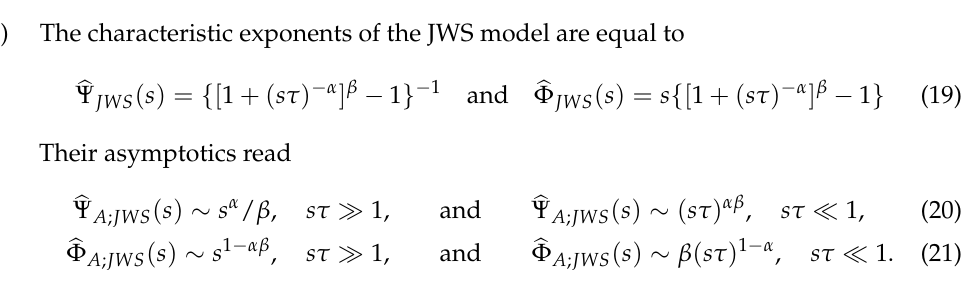
Figure 2. Plot presents the comparison between characteristic exponents (cid:98) Ψ KWW ( s ) (red solid curve no. I ) and (cid:98) Ψ HN ( s ) (brown dot-dashed curve no. Ib ), as well as between partner functions (cid:98) Φ KWW ( s ) (blue solid curve no. II ) and (cid:98) Φ HN ( s ) (green dashed curve no. IIb ). (cid:98) Ψ KWW ( s ) and (cid:98) Φ KWW ( s ) are calculated with the help of Equation (8) where we use α KWW = 1/3, τ = 1. The characteristic exponents (cid:98) Ψ HN ( s ) and (cid:98) Φ HN ( s ) are given by Equation (16) where α HN = 5/6 and β HN = 2/5. The comparison between the characteristic functions is made with the factor [ Γ ( 1 + 5/6 )] − 1 which is multiplied by (cid:98) Ψ HN ( s ) and divided by (cid:98) Φ HN ( s )